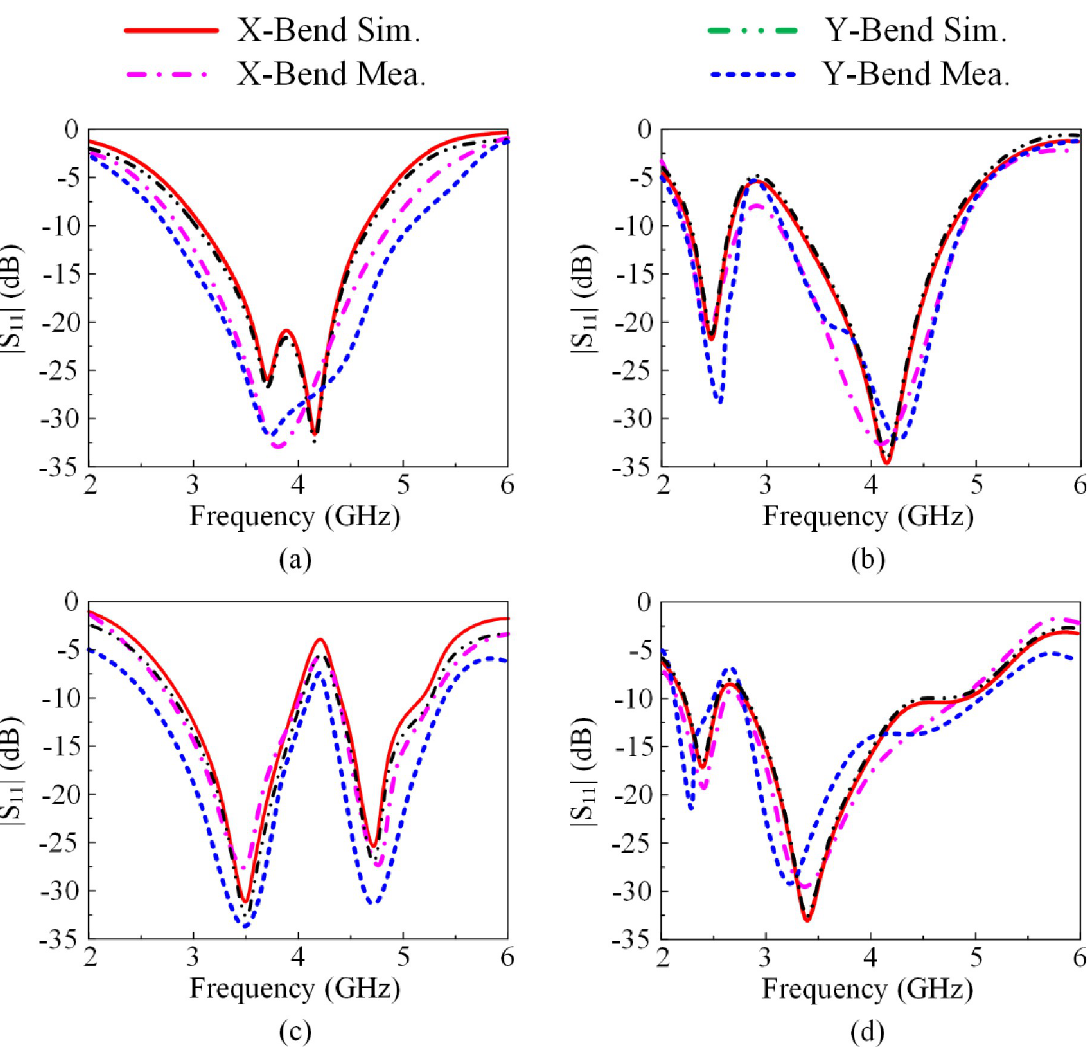
Fig 13. The reflection-coefficient response of the proposed antenna when wrapped around a cylinder under various PIN diode switching scenarios, (a) case-00, (b) case-01, (c) case-10, and (d) case-11.